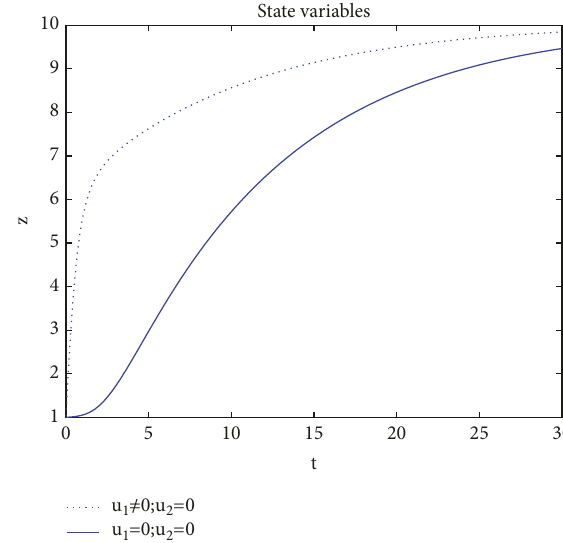
Figure 1: Evolution of number of 𝑥(𝑡) with or without control.